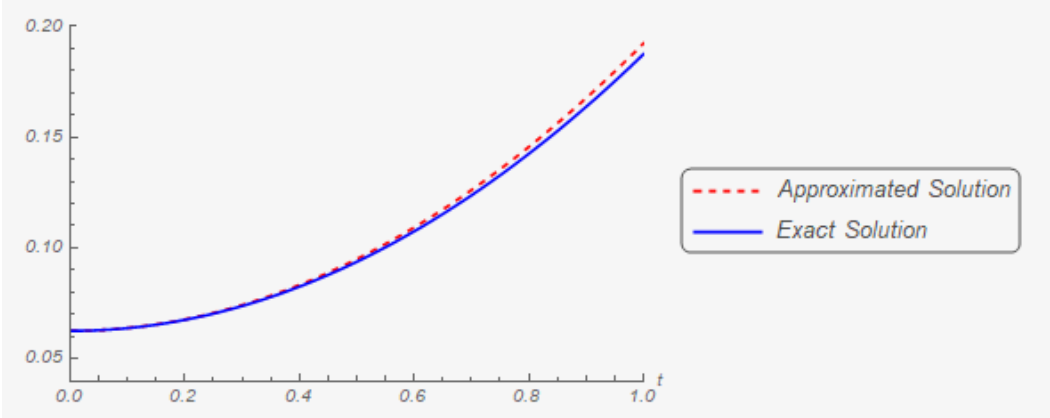
Figure 9. The first component of the exact solution and its two hundredth